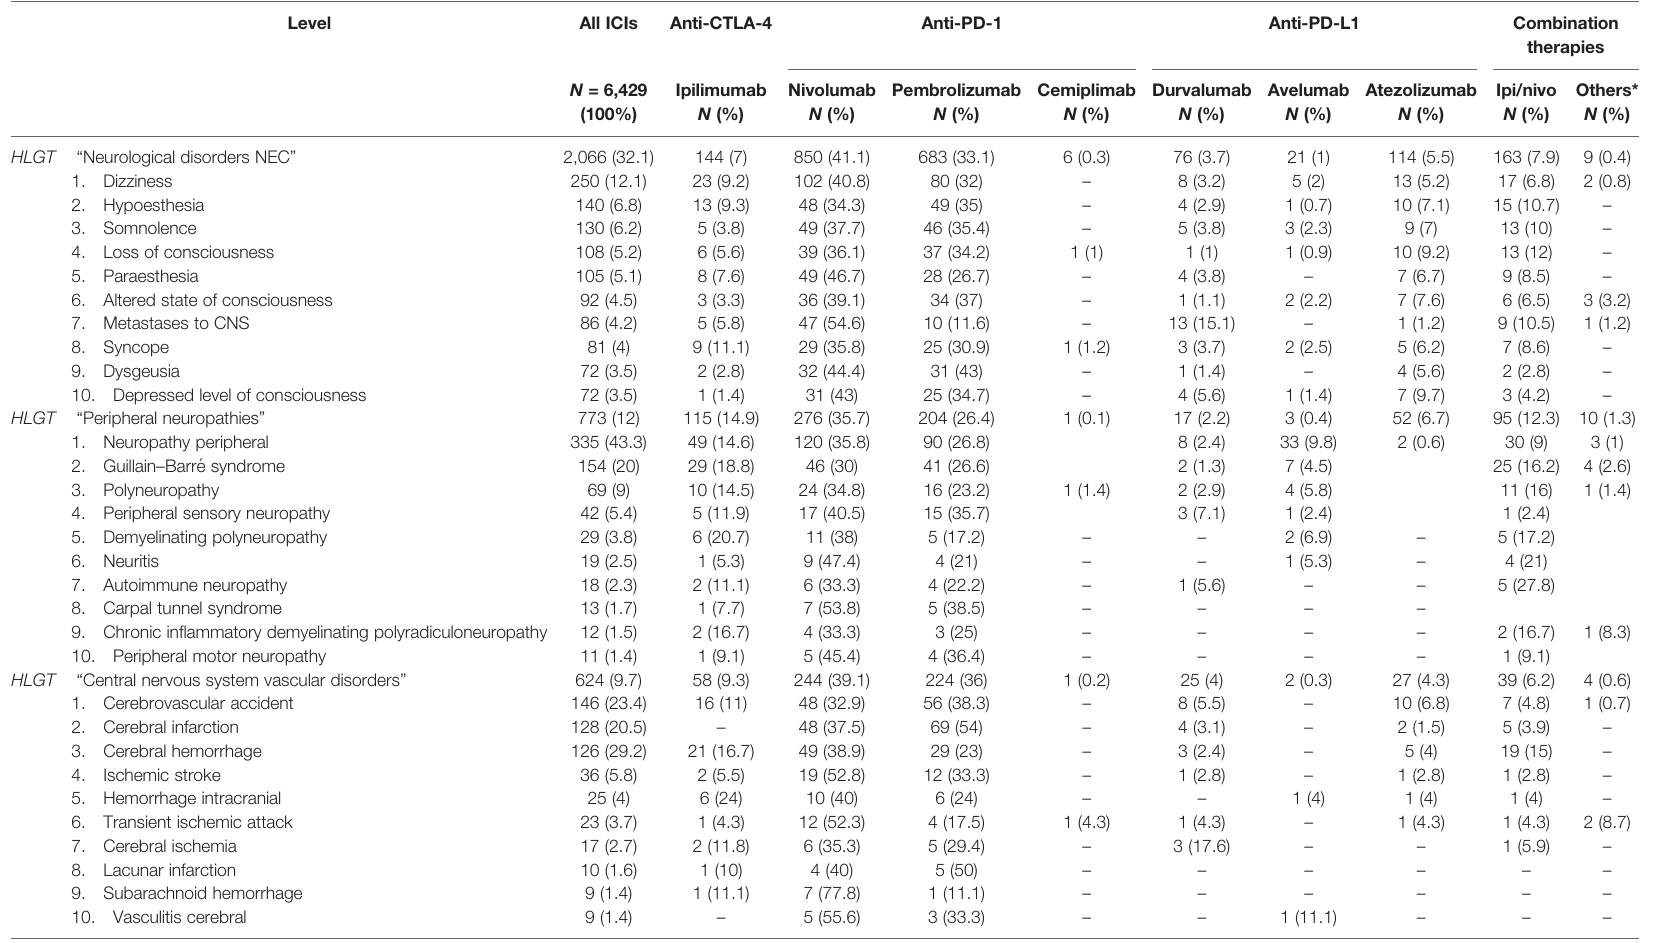
TABLE 5 | Top 10 ICI-related neurological complications belonging to the three most described High-Level Group Terms (HLGTs) in EudraVigilance until February 7, 2020, categorized by ICI treatments